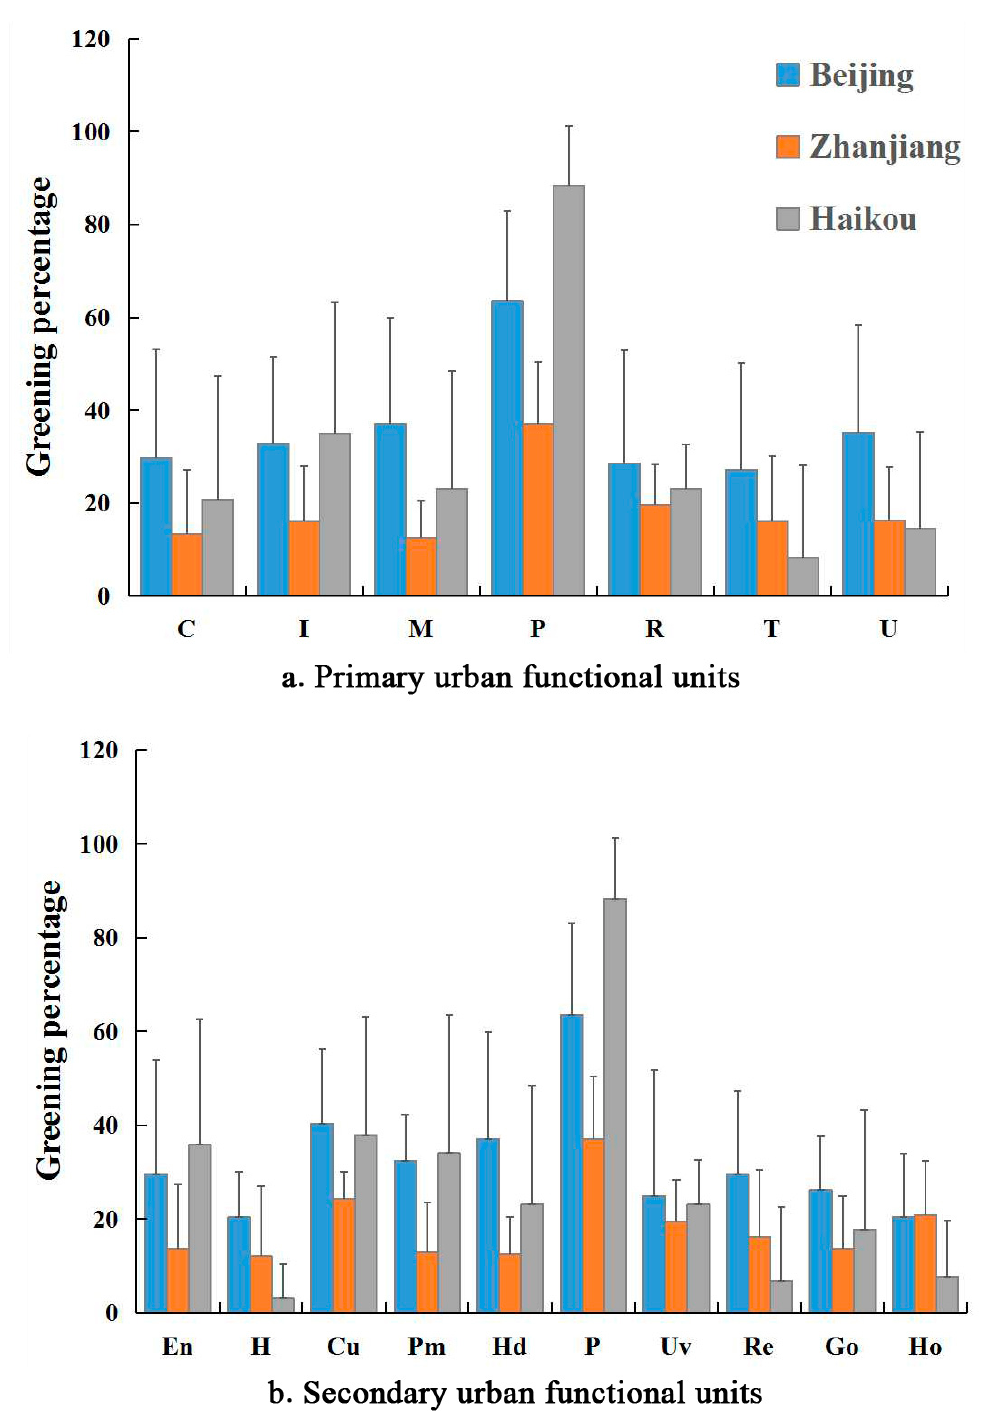
Figure 5. Greening percentages of both primary ( a ) and secondary ( b ) urban functional units found within Beijing, Zhanjiang, and Haikou.